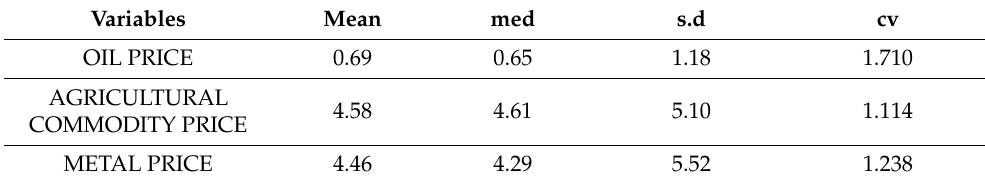
Table 2. Descriptive statistics of global